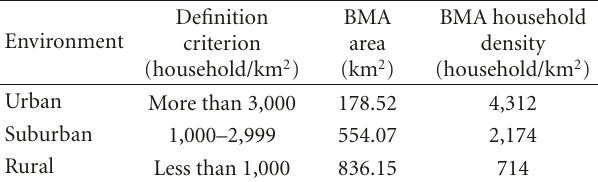
Table 11: Demographic information of